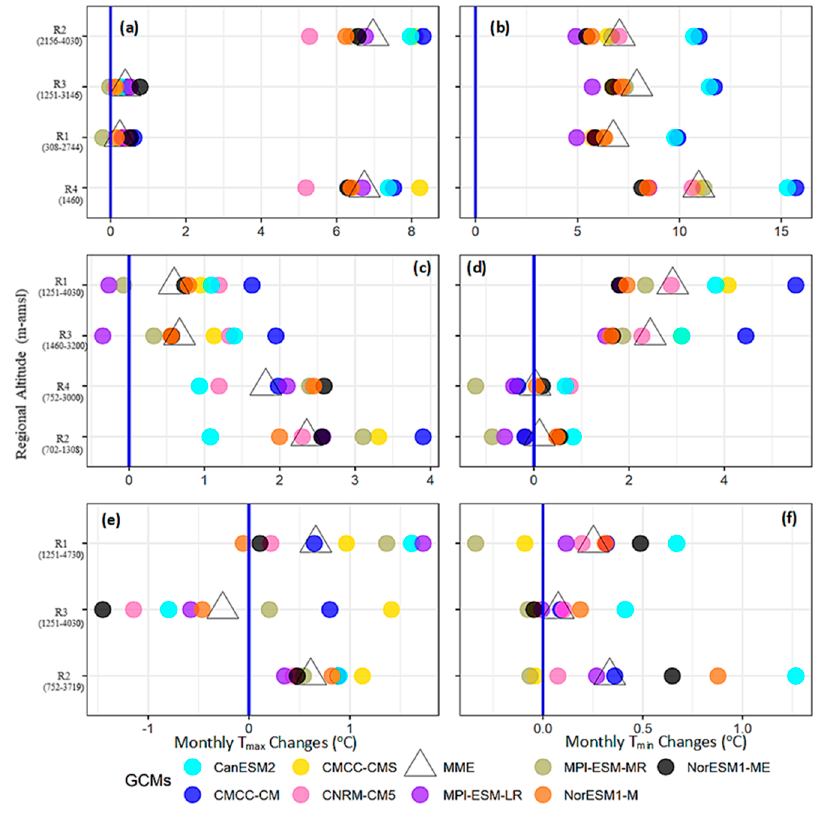
Figure 9. Same as Figure 5 but defining seasonal temperature changes during 2071–2100 under RCP8.5 using the high ‐ altitude UIB regionalization experiment ( a – f ).